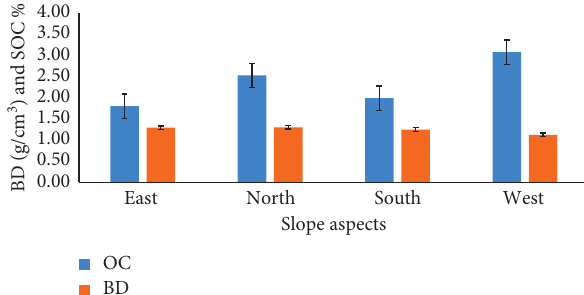
Figure 2: Bulk density and SOC across slope aspects (BD: bulk density in gram per centimeter cubic; OC: soil organic carbon in